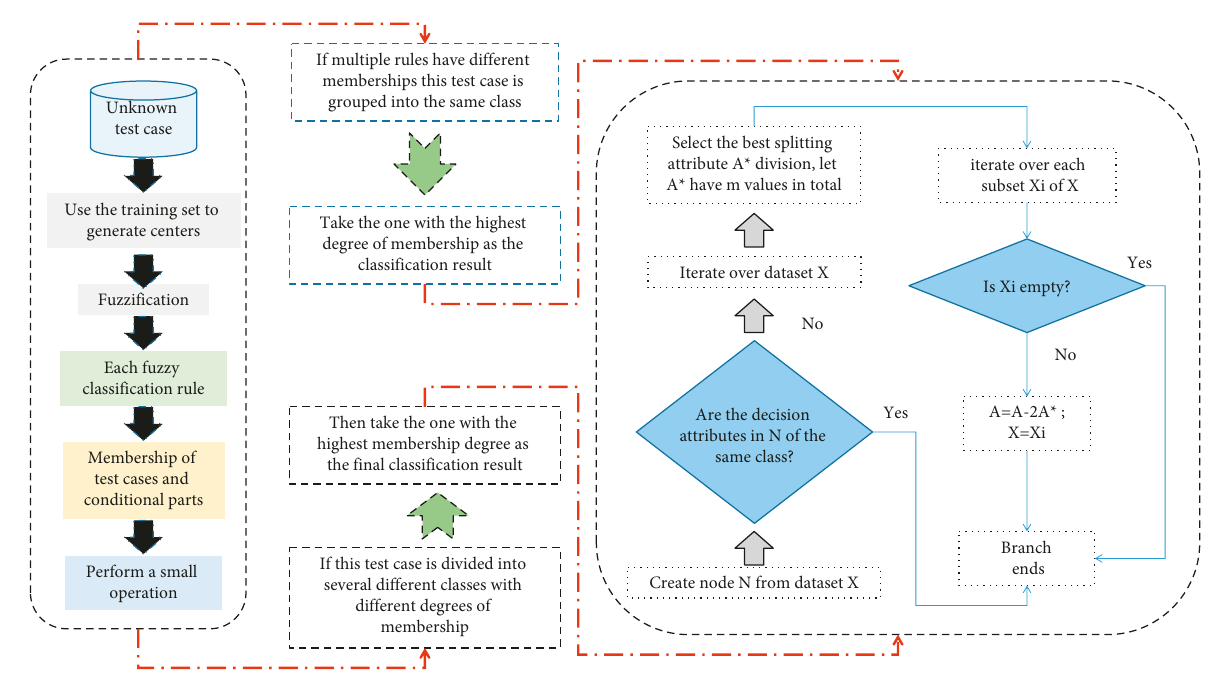
Figure 2: Flowchart of fuzzy decision tree algorithm.